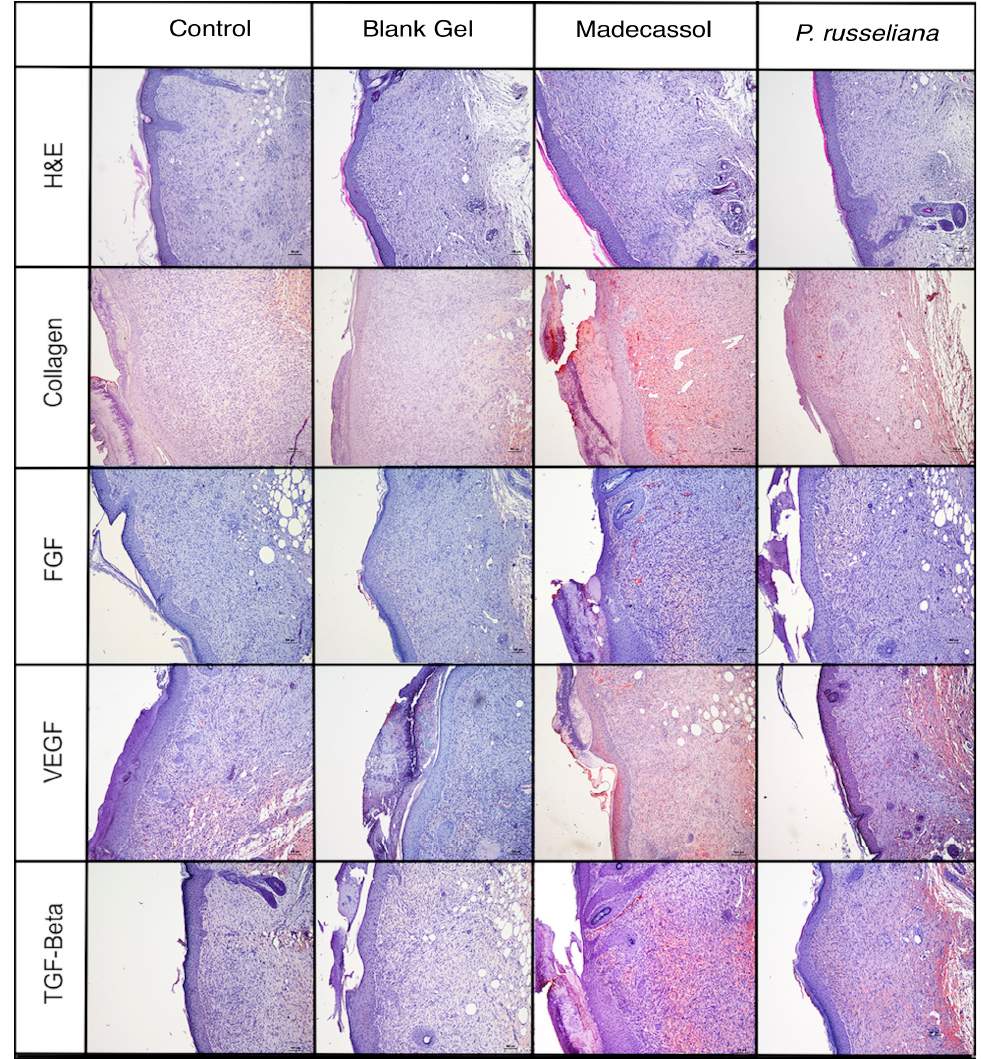
Figure 6. Histopathological view of injured tissues of the untreated (control), blank gel, extract gel, and Madecassol groups on the 10th day after wound incision (magnification 10×).